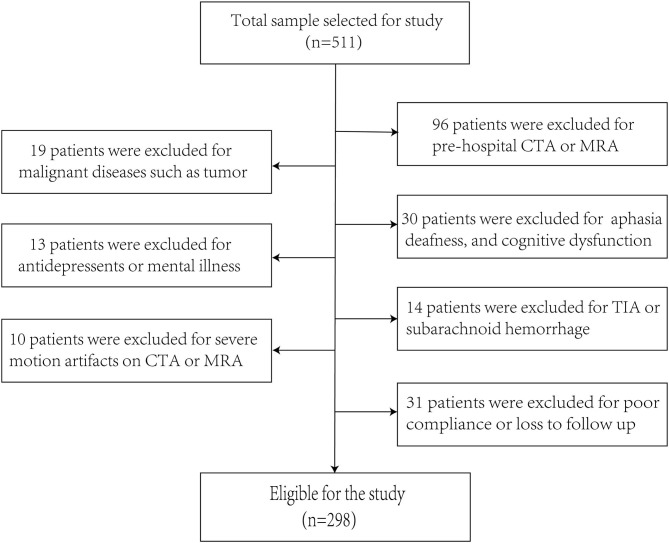
The enrollment flow chart of this study. A flowchart drawn according to inclusion and exclusion criteria.